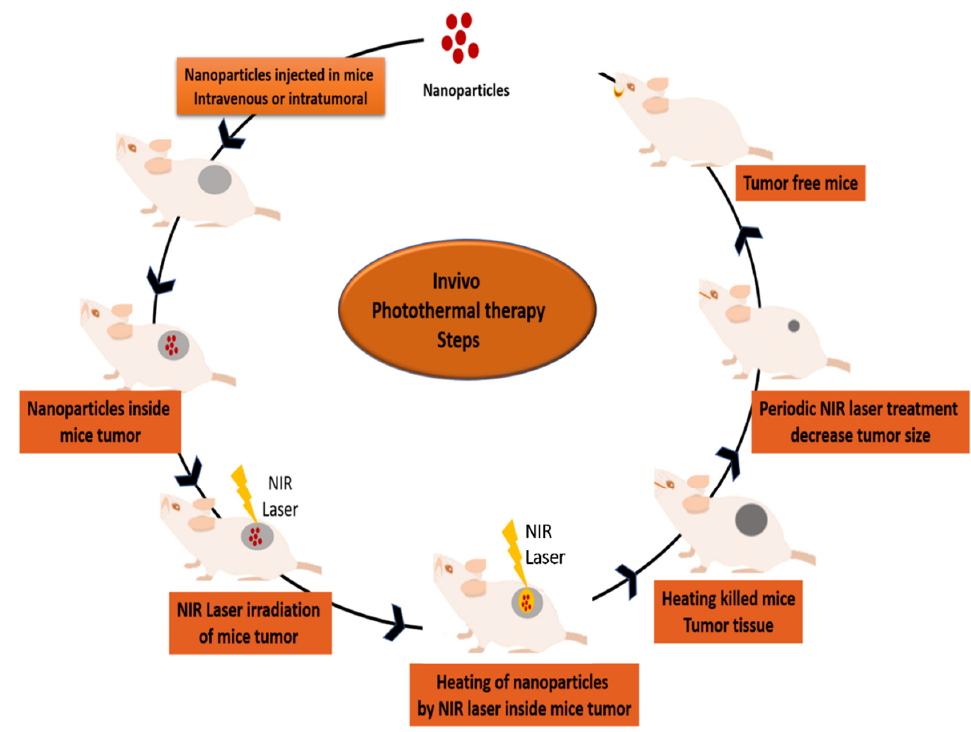
Figure 5. Steps for in vivo photothermal therapy.